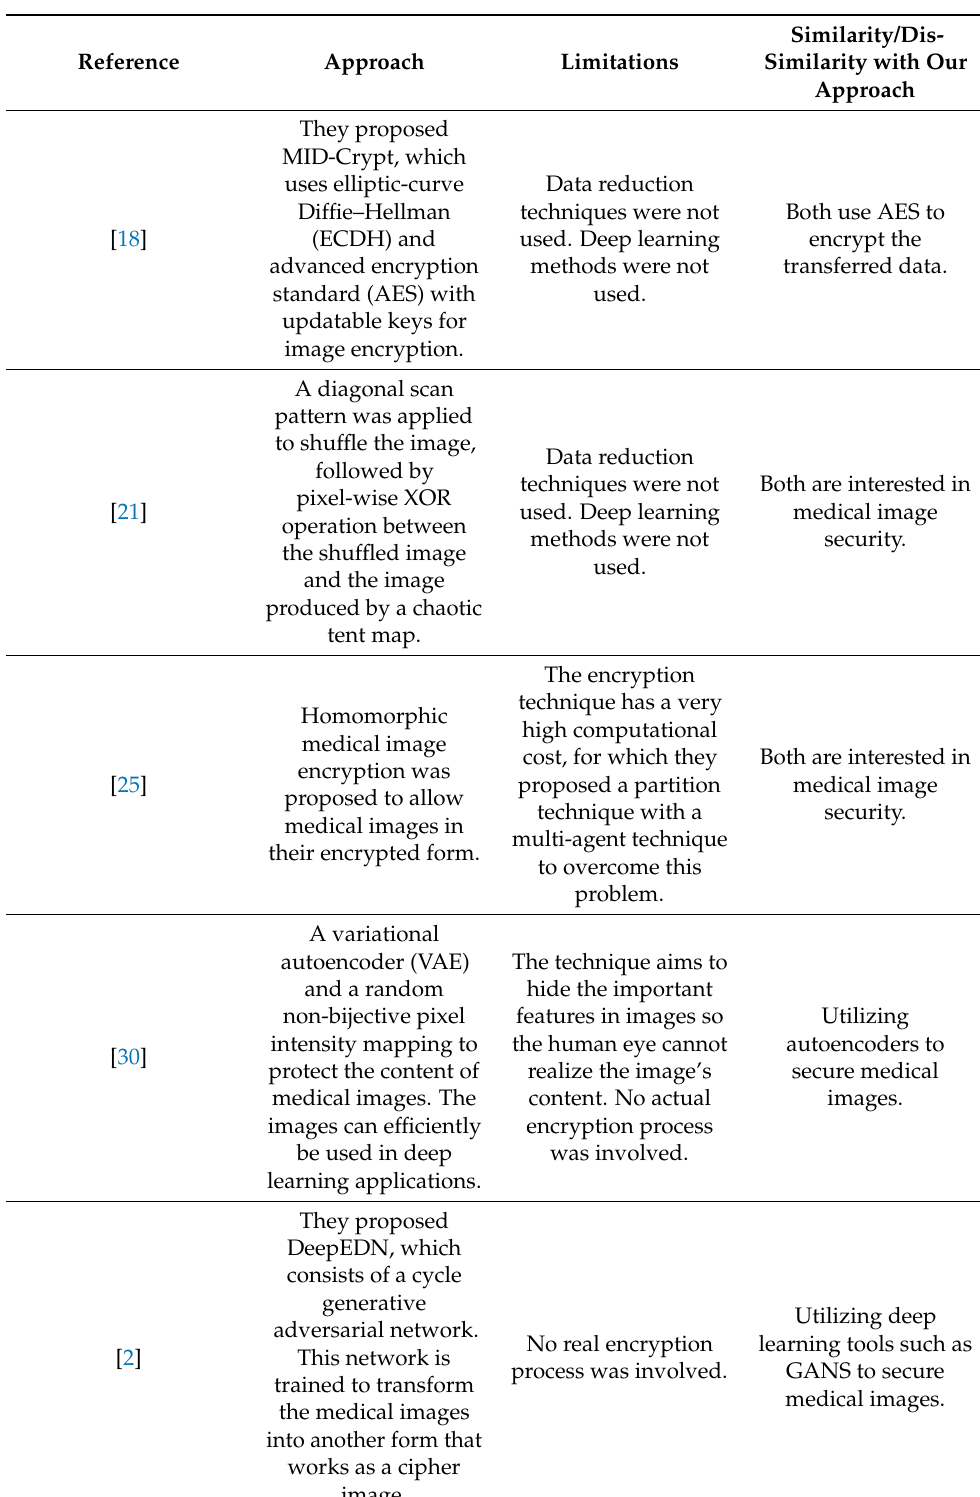
Table 1. Summary of selected related